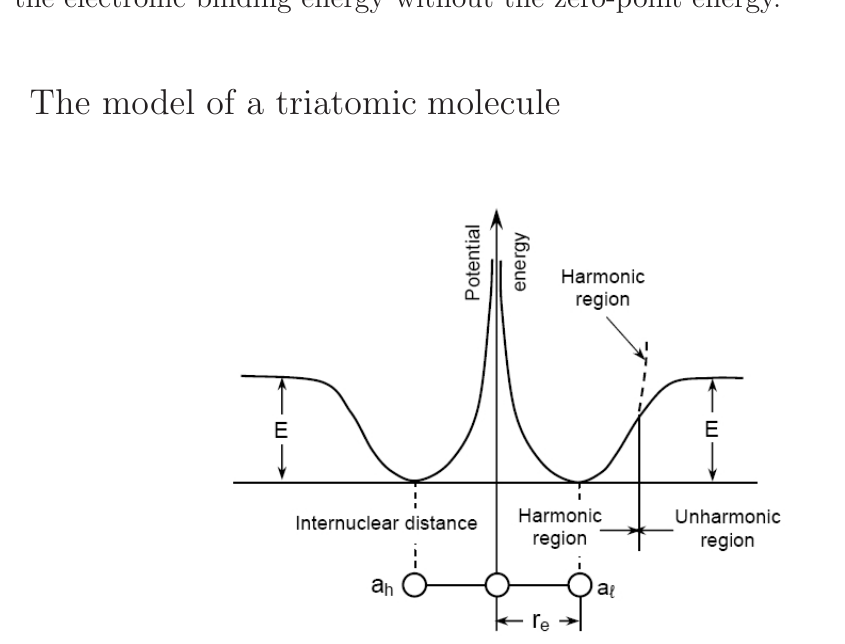
Fig. 15 A triatomic molecule restricted to linear vibration with light ( a l ) and heavy ( a h ) atoms and its potential energy